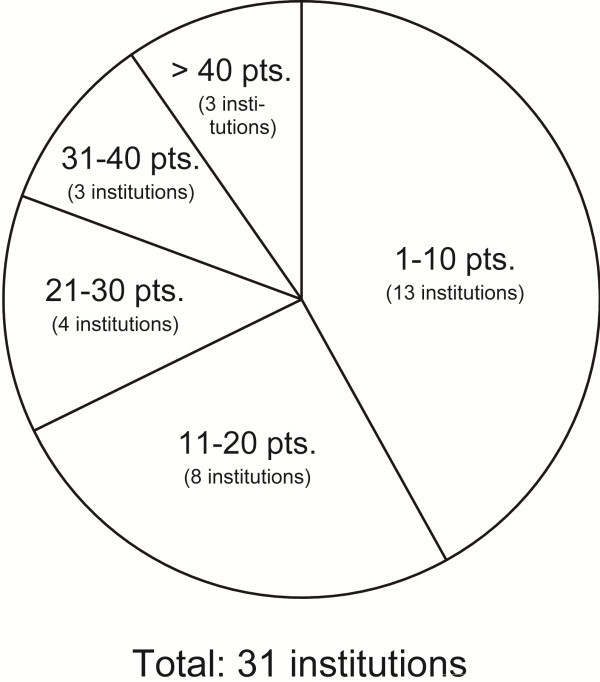
Distribution of institutions by number of patients treated during 2000–2011. The number of patients varied considerably among institutions.